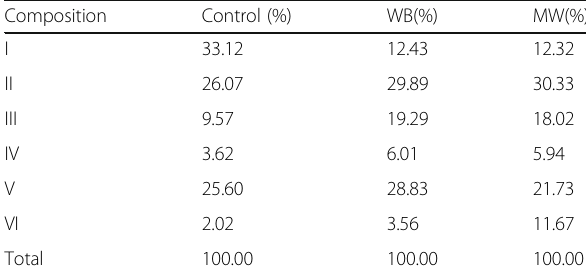
Table 2 The content of each component in 33% basicity chromium sulphate tanning liquor warmed under different methods